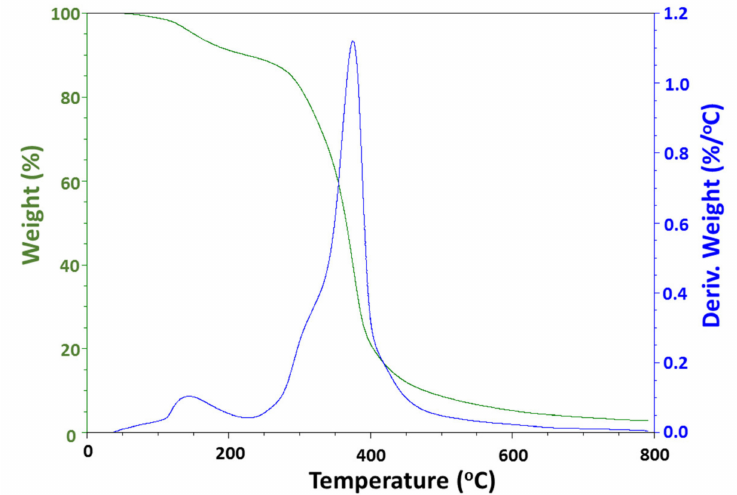
Figure 6. TGA / DTA graph showing the decomposition of as-obtained